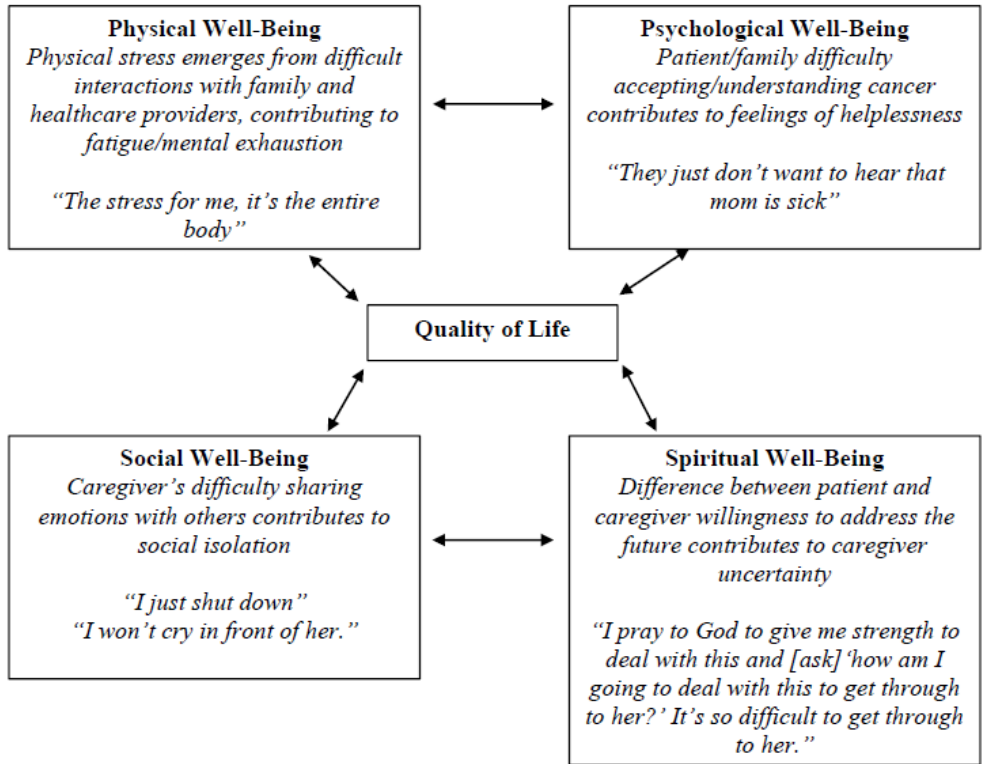
Figure 1. City of Hope Quality of Life model applied to caregiver communication burden.